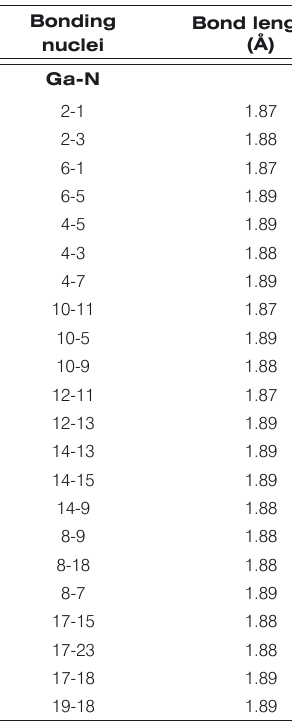
Table 2. Structural parameters of the Li-capped (4, 4) GaNNT. Bonding nuclei